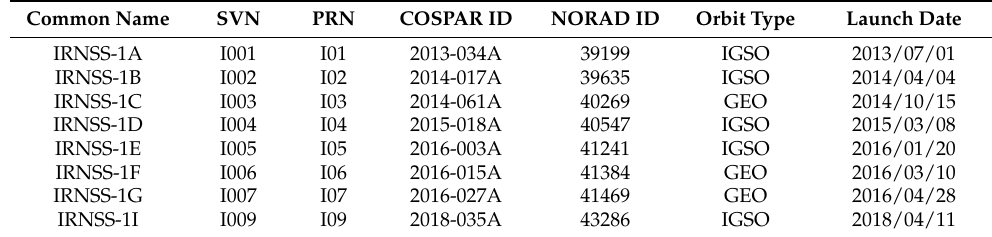
Table 1. Information about IRNSS